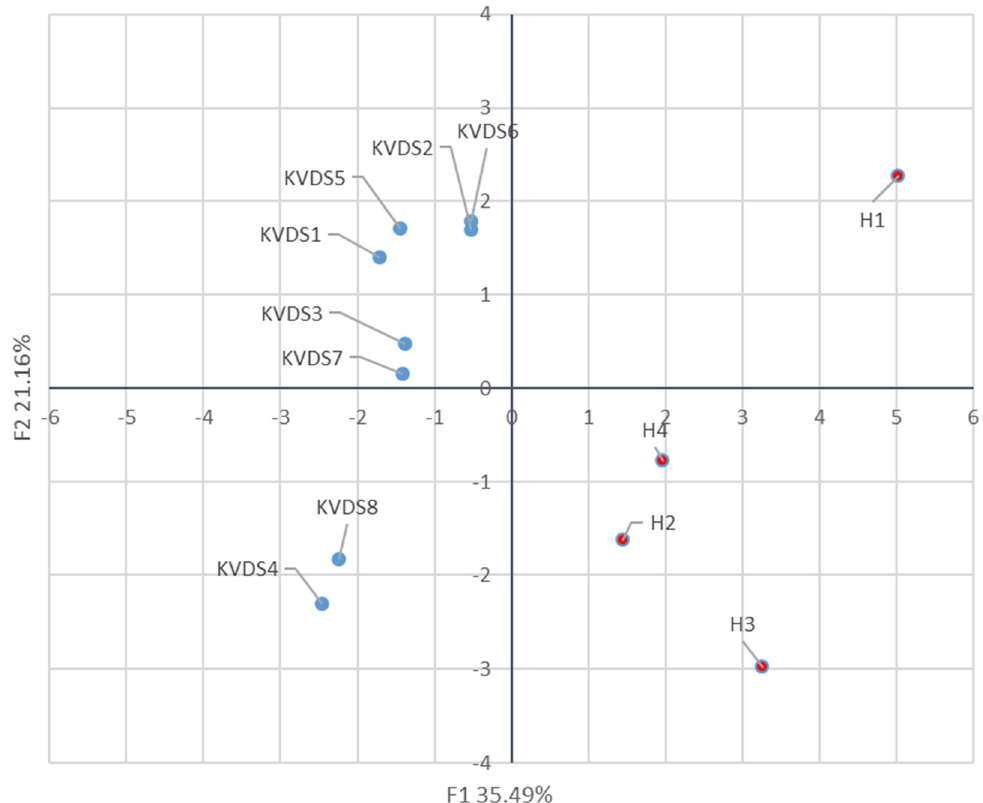
Figure 2. Two-dimensional principal component analysis (PCA) showing the distribution of samples from healthy and KVDS affected plants on the basis of bacterial species presence and abundance. H: healthy root samples, KVDS: symptomatic samples.